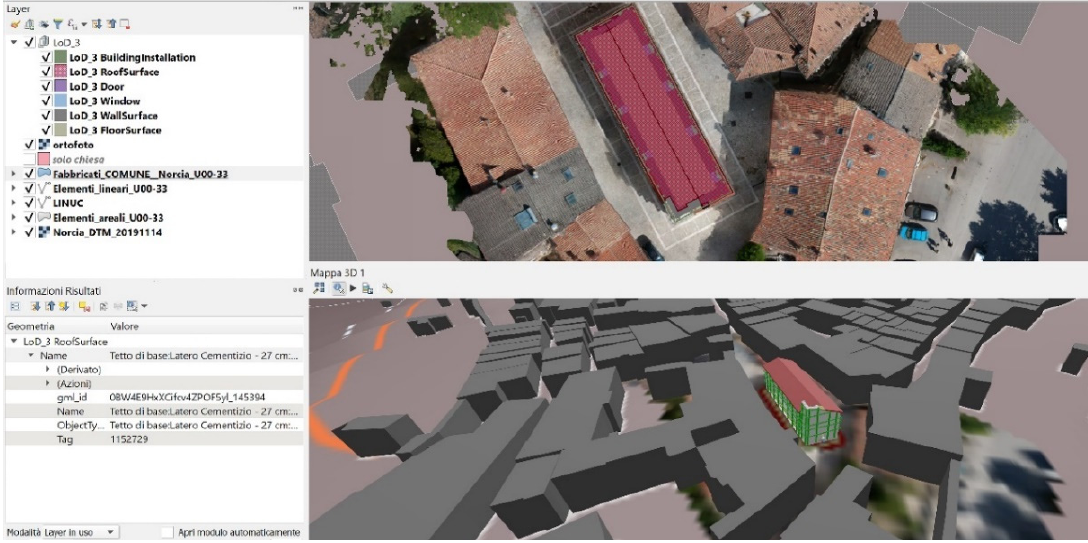
Figure 21. QGIS 3D visualisation of the .GML file of the church and its context.